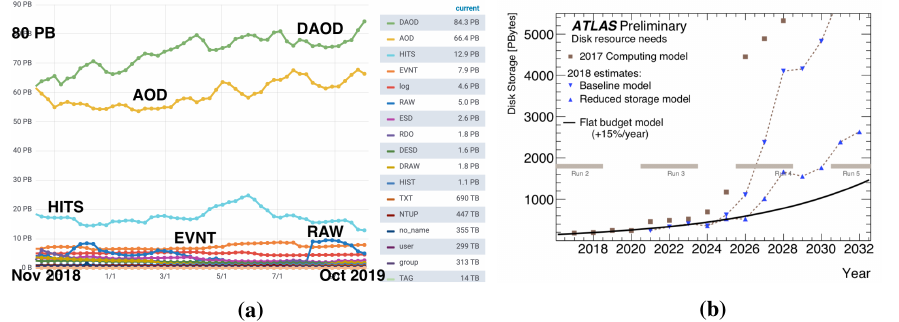
Figure 3: (a) Distribution the ATLAS data formats on disk from November 2018 until Octo- ber 2019. (b) Projections of ATLAS disk space needs for the next years